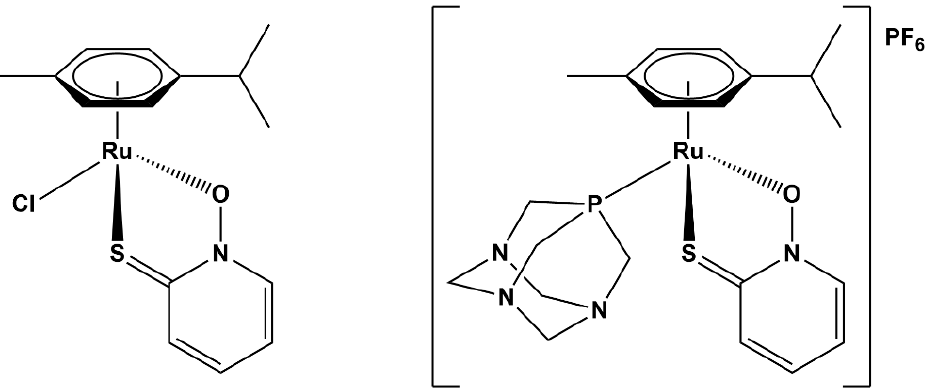
Figure 1. Parent organoruthenium–pyrithionato chlorido 1 and pta complex 2 . In addition, compound 1 was found to strongly inhibit cholinesterases, with virtually no adverse physiological responses to the neuromuscular system, which is a beneficial feature for potential anticancer drug candidates